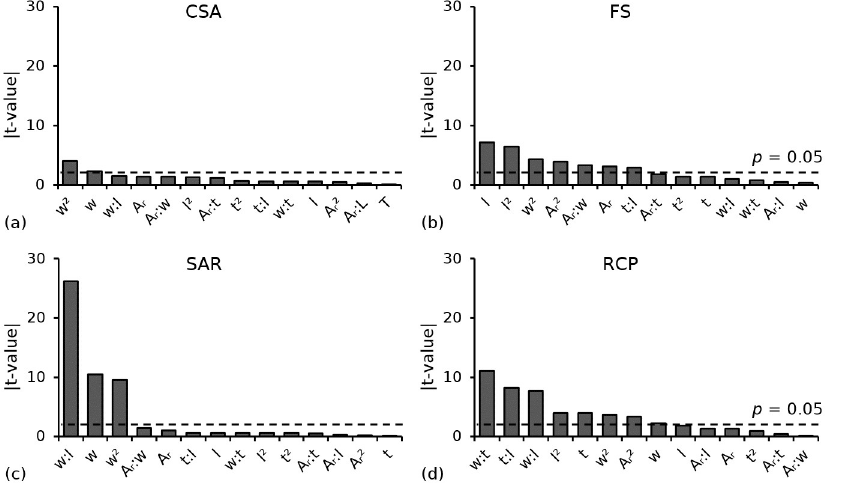
The Pareto fronts (Fig 15) highlight the trade-offs between each set of performance metrics, with better designs lying towards the bottom left corner. Trade-offs were observed for CSA vs . FS , CSA vs . SAR , FS vs . RCP and SAR vs . RCP , whilst no trade-offs were observed for CSA vs . RCP or FS vs . SAR . Trade-offs occurred as a result of conflicting requirements for stent design, i.e. geometric and/or material parameters that improve one metric often negatively affect at least one of the other metrics.